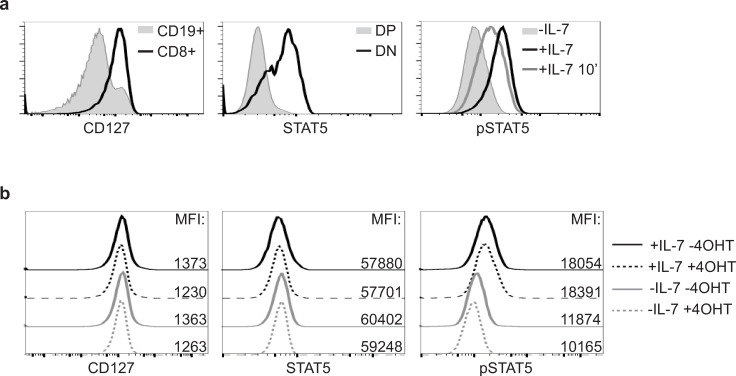
Ikaros does not affect the level of activated STAT5 proteins.(a) Controls for the analysis by flow cytometry of the expression of CD127 on splenic CD19+ B cells or CD8+ T cells (left panel), total STAT5 in double negative (DN) and double positive (DP) thymocytes (middle panel) and pSTAT5 in BH1 cells cultured with or without IL-7, or re-stimulated for 10 min after IL-7 withdrawal (+IL-7 10') (right panel). (b) Flow cytometry analysis of BH1-IkER cells upon 24h culture and stained as indicated. Numbers indicate the mean fluorescence intensities (MFI) of the corresponding samples.